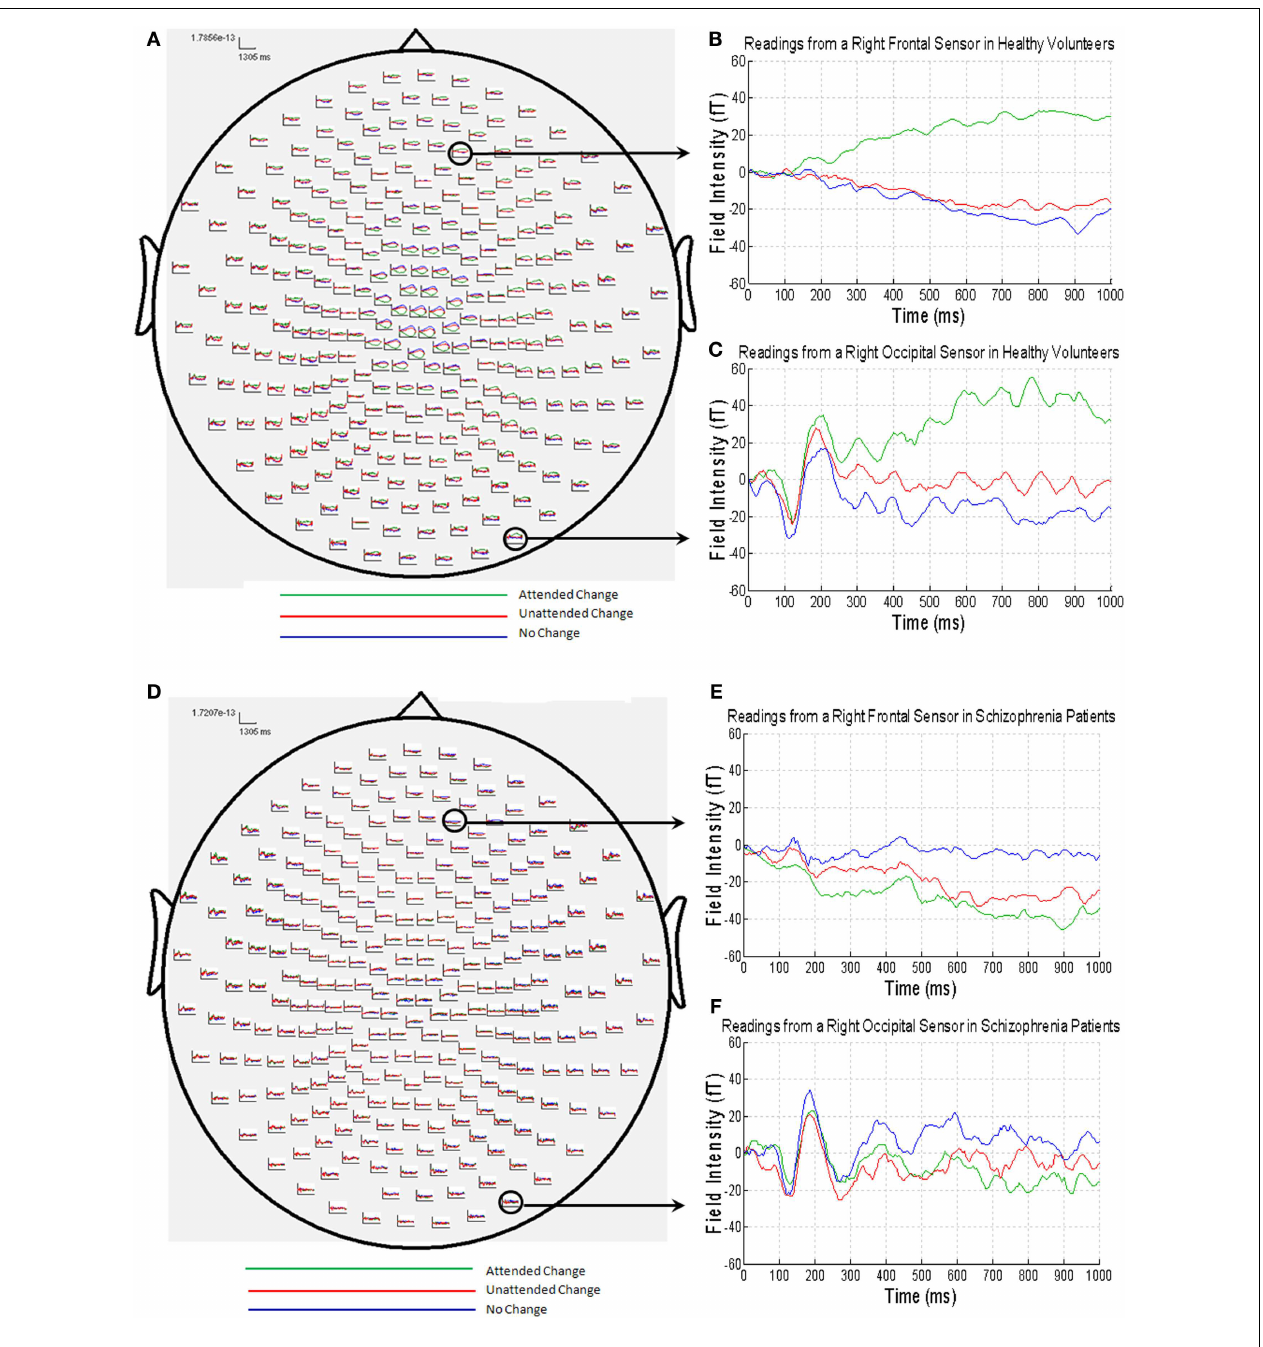
stimulus presentation; (D) MEG responses averaged over all of the patients with schizophrenia (colors as above); (E) MEG data from a right frontal sensor; (F) MEG data from a right occipital sensor, showing the visual evoked field in response to stimulus presentation.